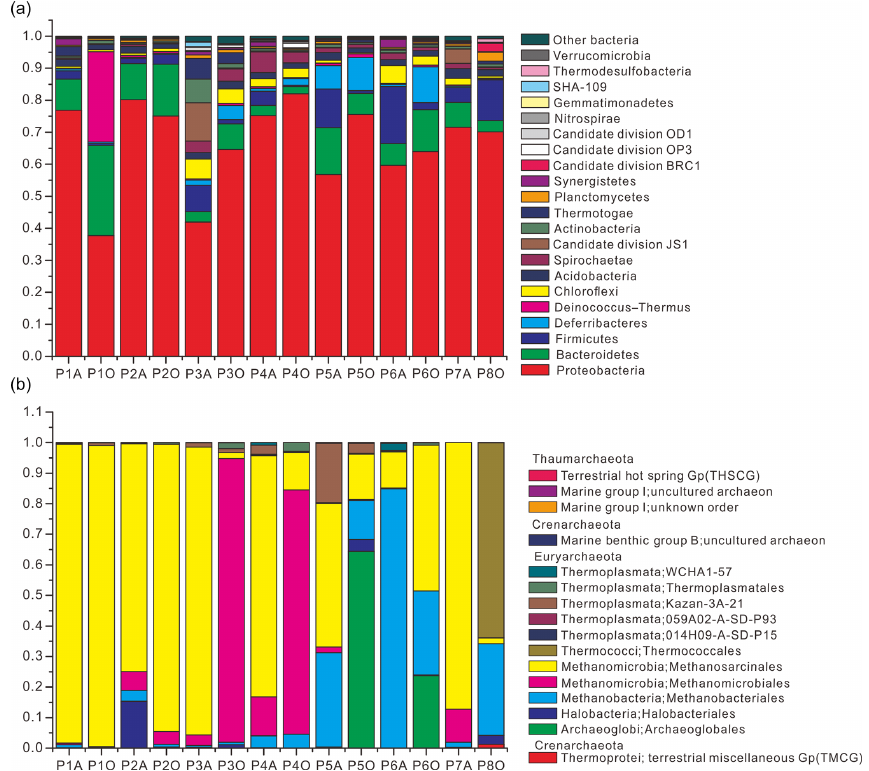
Figure 1. Relative abundance of bacteria (a) and archaea (b) from 14 aqueous- and oil-phase samples. Bacterial community was taxonom- ically assigned at the level of phylum. Those phyla with an average abundance of all samples below 0.1% were combined into the “other bacteria” category. The archaeal community was taxonomically assigned at the level of